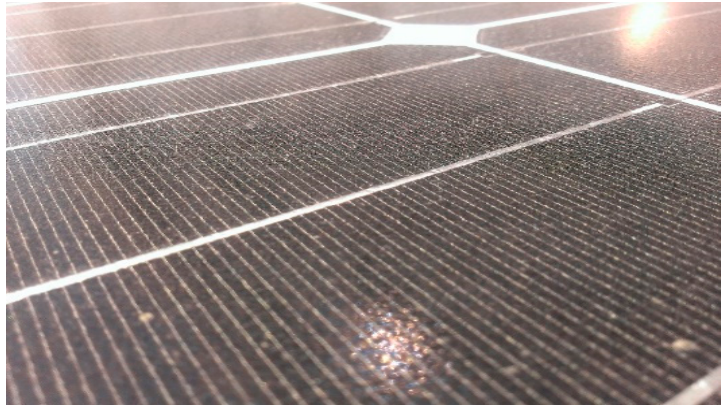
Figure 17. The dust settled on the panel surface.